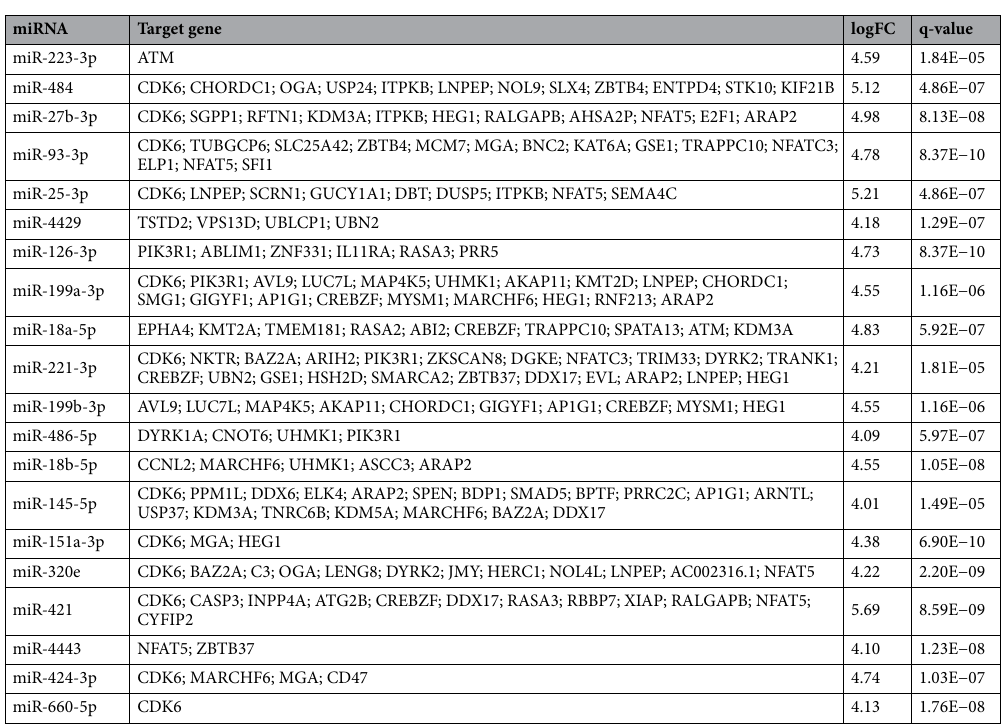
Table 1. Top differentially expressed miRNAs (logFC > ± 4) with negatively correlated mRNA targets (Pearson’s correlation r ≤ − 0.85). The logarithmic fold change (FC) is given for the expression between classical and nonclassical monocytes in the control